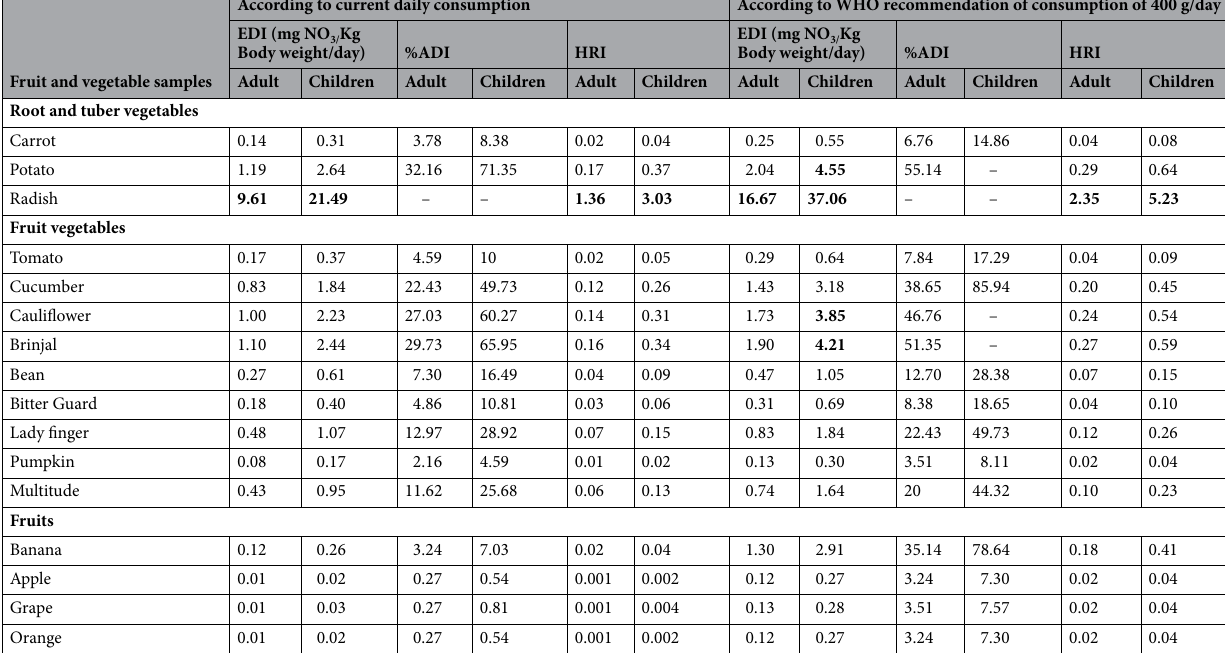
Table 2. Estimated Daily Intake (EDI) and Health Risk Index (HRI) for the Fruits and vegetables in accordance with the current daily consumption and WHO/FAO recommendation for adult and